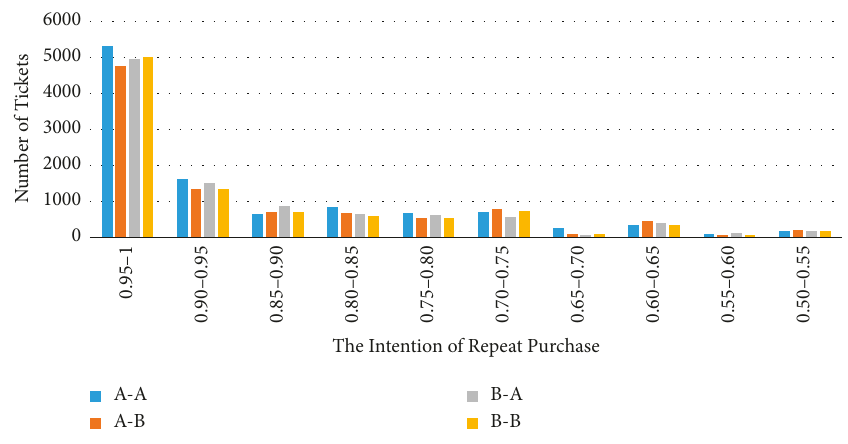
Figure 8: The number of tickets in four